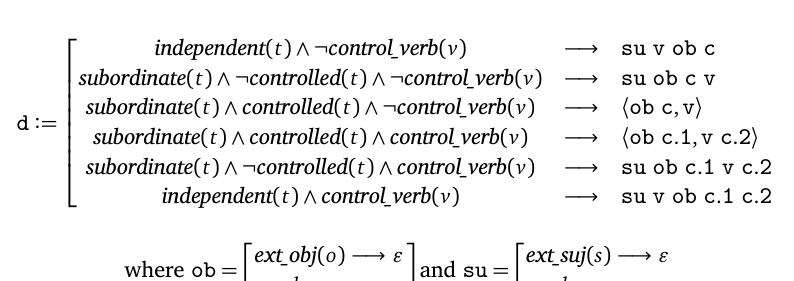
Figure 24: Dutch linearization for production p